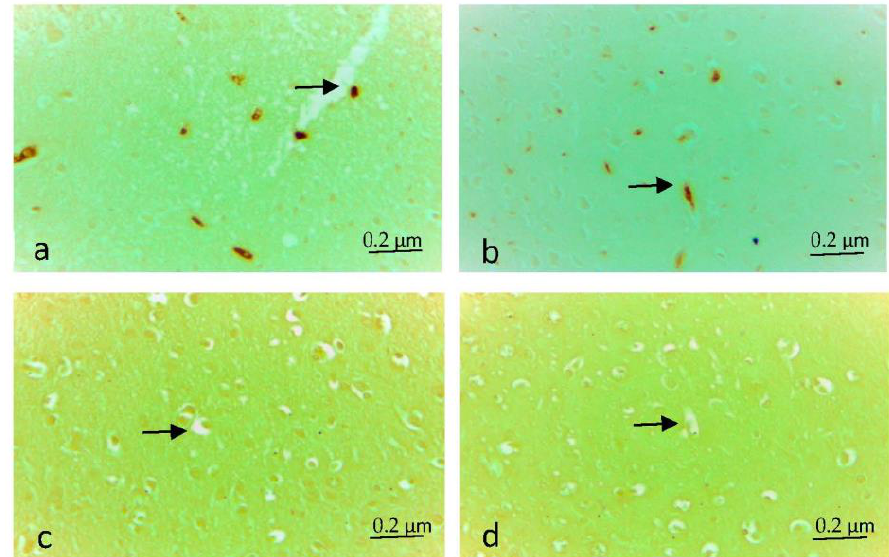
Figure 2. ( a , b ) Caspase-3 immune positive cells (arrow) in the electric field group, × 40. ( c ) Caspase-3 immune negative cells (arrow) in the electric field + Juglone group, × 40 ( d ) Caspase-3 immune negative cells (arrow) in the Control group, × 40.